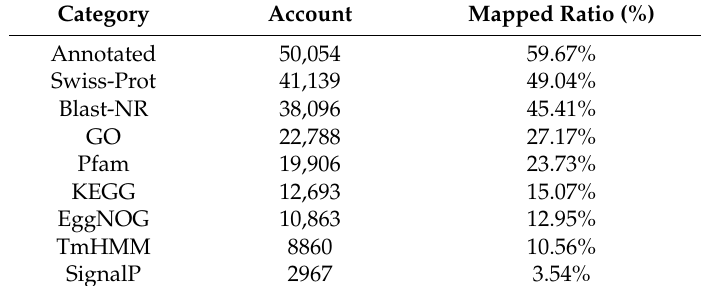
Table 3. Summary of the annotations for the assembled unigenes in public databases.